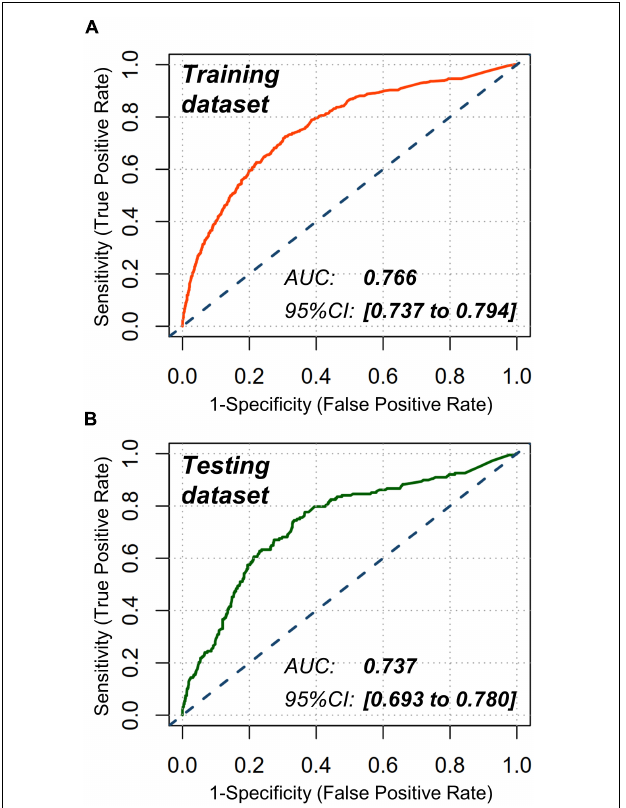
FIGURE 4 | Receiver operating characteristic (ROC) analyses. Nomogram showed a good discrimination for CA-AKI in (A) training dataset (AUC: 0.766; 95% CI: 0.737 to 0.794) and (B) testing dataset (AUC: 0.737; 95% CI: 0.693 to 0.780). AUC indicates area under the curve; CI, confidence interval.